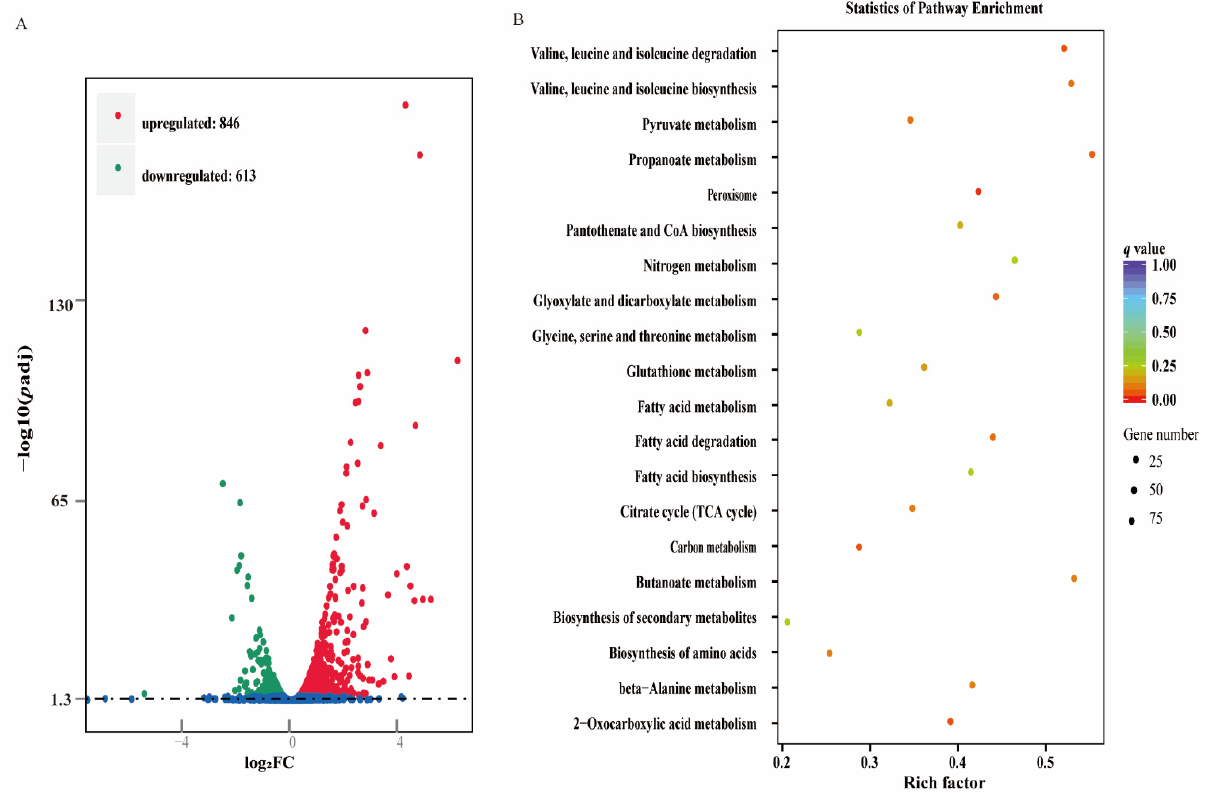
Figure 4. ( A ) Volcano map of differentially expressed genes (DEGs) for treated vs. control. Different colours (red, green, and blue) represent upregulated, downregulated, and no significant changes, respectively. ( B ) The most abundant KEGG pathways for differentially expressed genes.